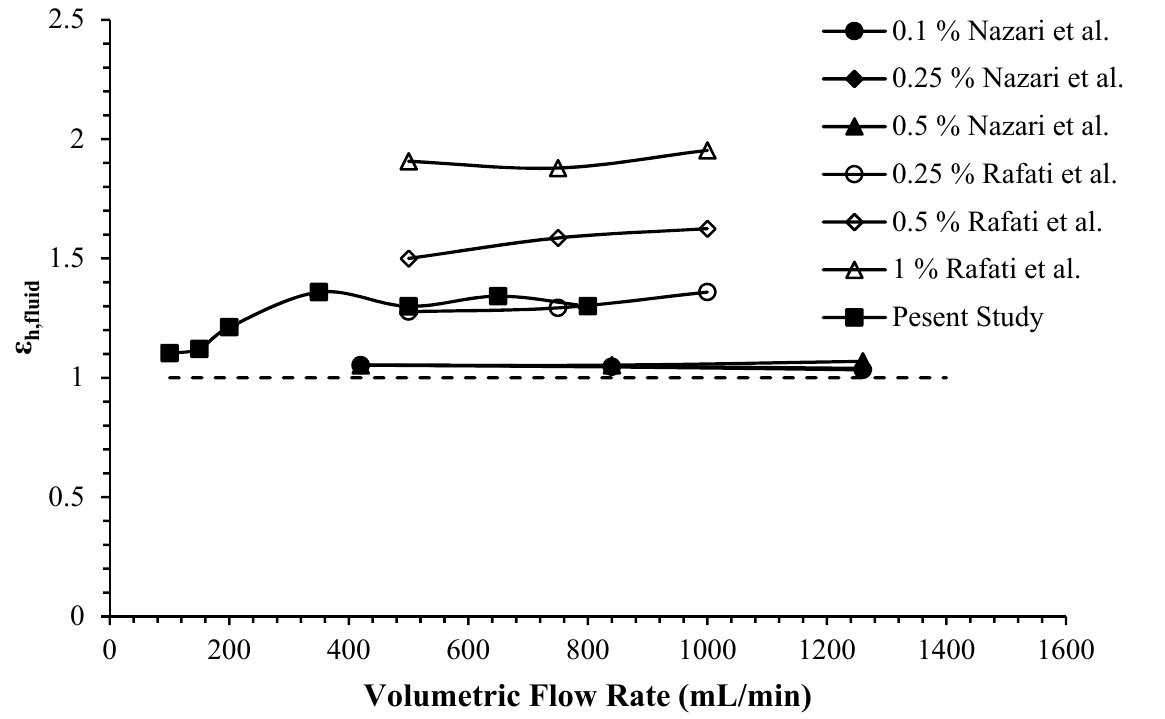
Figure 10. Variation of the nanofluid thermal performance with volumetric flow rate (Empty chan- nel) [2,3].